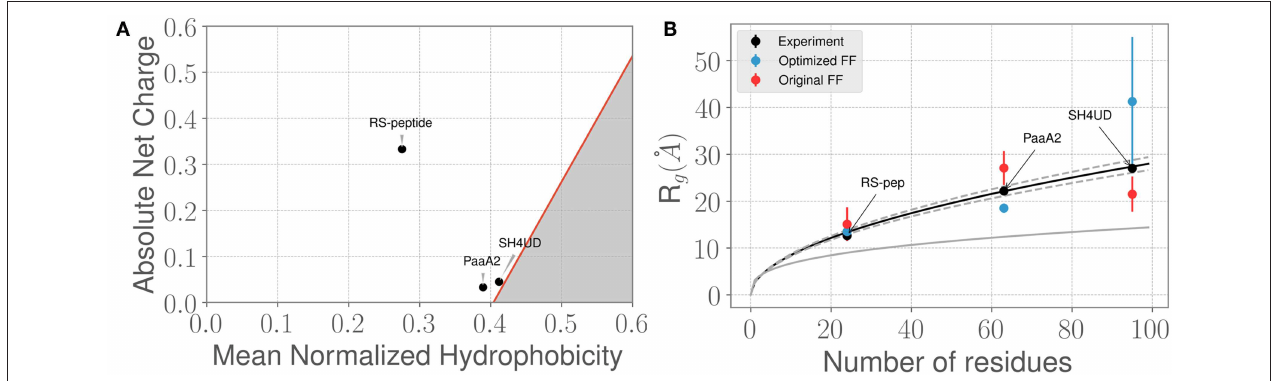
FIGURE 2 | Three prototypical IDP systems chosen for the ForceBalance-SAS approach indicate diverse structural characteristics. (A) The mean normalized hydrophobicity vs. the absolute net charge (Uversky) plots indicate that the RS-peptide system is more disordered than the other two systems. The red line is used to mark the boundary between disordered proteins vs. more folded/globular proteins; the gray highlighted area is indicative of the region that is enriched for folded/ globular proteins ( Uversky, 2011). (B) Comparison of the SAXS determined experimental radius of gyration (R g ) values vs. the R g values predicted using simulations from the original FF (red dots) and the optimized FF (blue dots). The theoretical R g values predicted from the Flory equation for IDPs (see Results section) is shown in black, along with expected standard deviations (gray dotted lines). The corresponding R g values for a globular protein with the same number of amino acid residues is shown for reference (gray solid line). Additional details of the sequence/structural properties of the IDP ensembles considered here are provided in the supporting information.